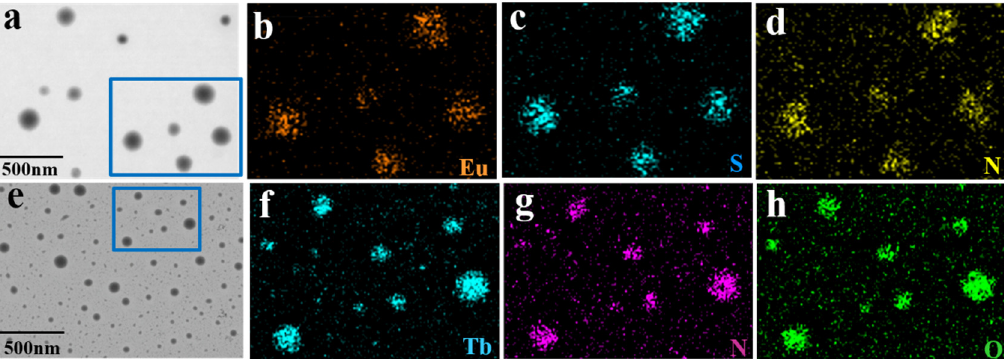
Figure 3. ( a ) High-resolution TEM of sample B, ( b ) elemental mapping of the distribution of Eu, ( c ) elemental mapping of the distribution of S, ( d ) elemental mapping of the distribution of N. ( e ) High-resolution TEM of sample D, ( f ) elemental mapping of the distribution of Tb, ( g ) elemental mapping of the distribution of N, ( h ) elemental mapping of the distribution of O.